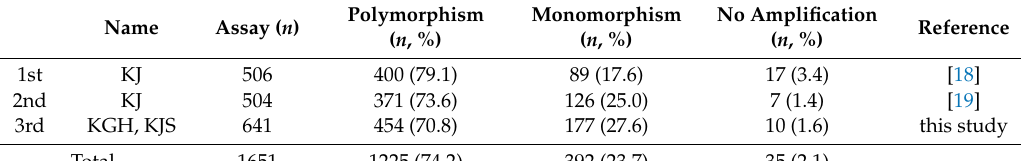
Table 4. Summary of KASP assays with Korean temperate japonica rice varieties.